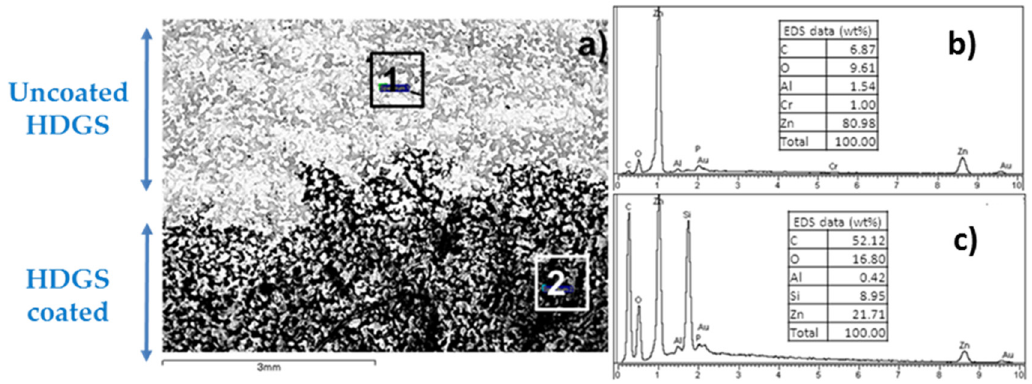
Figure 9. ( a ) SEM image of HDGS surface (backscattered mode) showing (1) uncoated and (2) coated areas with the localization of Electron Diffraction Spectroscopy (EDS) analysis ( b ) and ( c ) (including semi-quantitative analysis as inset).